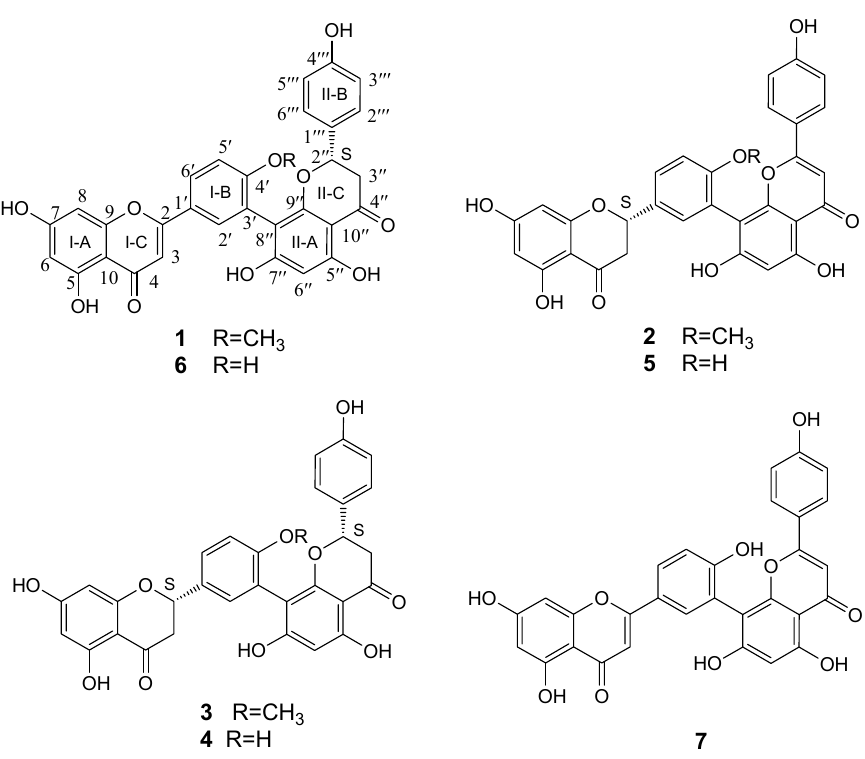
Figure 1. Chemical structures of compounds 1 - 7